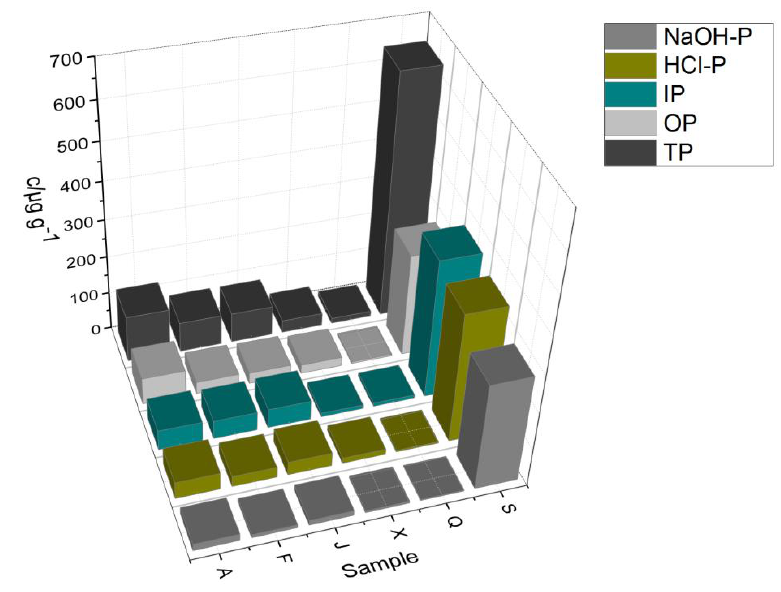
Figure 3. Concentrations of all P fractions among the rivers.